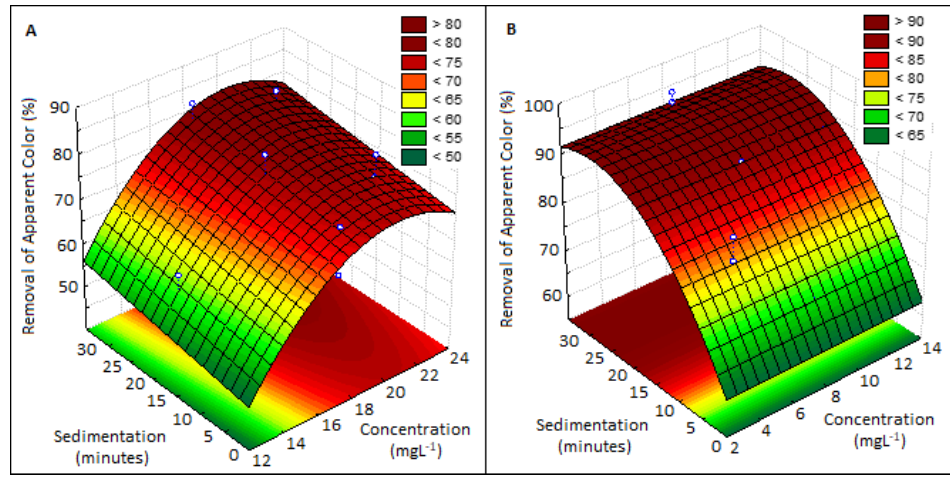
Figure 6. Surface graphics of the apparent color treatment using magnetite associated with ( A ) tannin and ( B ) Moringa oleifera.